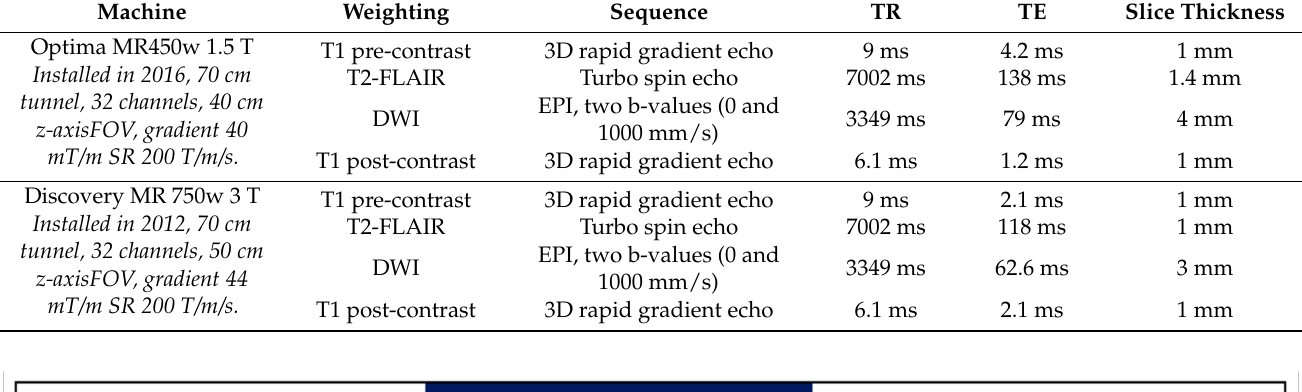
Table 2. MRI parameters.